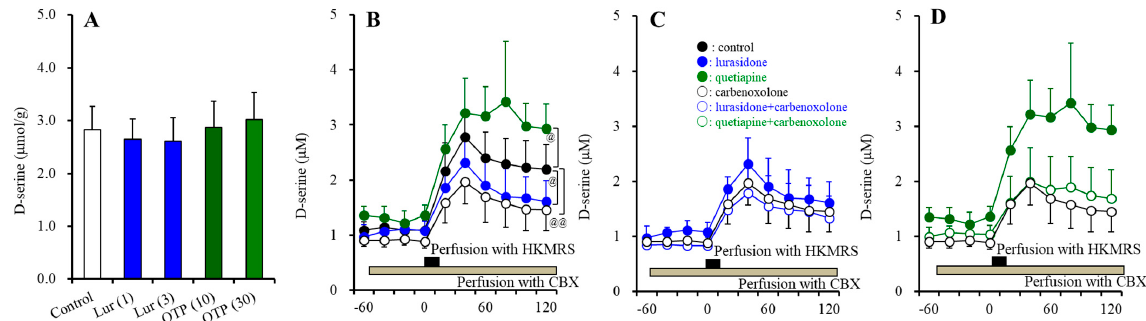
Figure 6. E ff ects of systemic chronic administration of e ff ective doses of lurasidone (Lur: 1 mg/kg/day for 14 d) and quetiapine (QTP: 10 mg/kg/day for 14 d) on intracellular ( A ) and extracel- lular ( B – D ) levels of D-serine. In panel ( A ), ordinate indicates mean ± SD ( n = 6) of intracellular levels of D-serine (µmol/g protein). In panels ( B – D ), ordinate indicates mean ± SD ( n = 6) of extra- cellular levels of D-serine (µM). Abscissa indicates time after HKMRS-evoked stimulation (100 mM